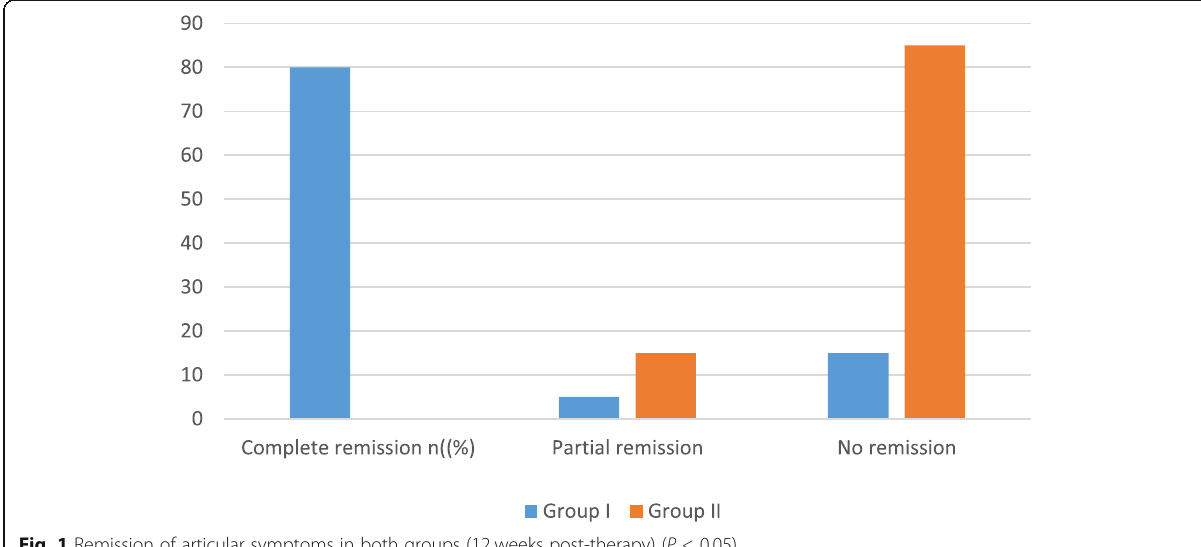
Fig. 1 Remission of articular symptoms in both groups (12 weeks post-therapy) ( P <